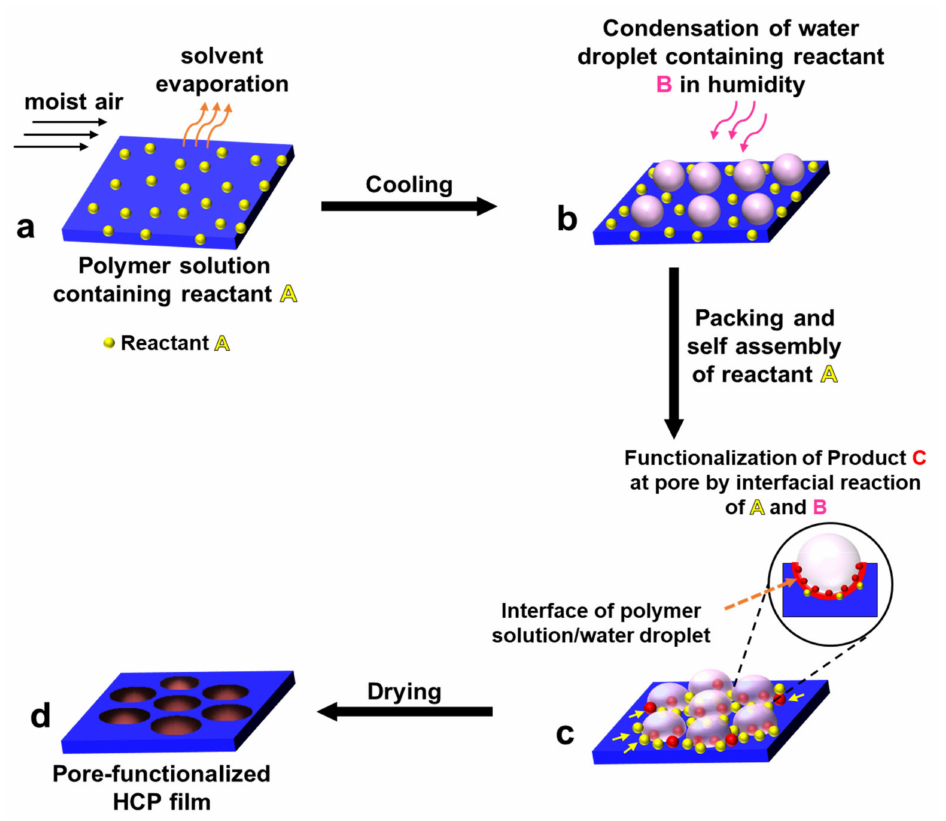
Figure 11. A sequence of stages of pore-selective functionalization by self-assembly accompanied by chemical reaction. ( a ) polymer solution containing reactant A, ( b ) condensation of water droplets containing counter reactant B, ( c ) functionalizing of product C at the pore by the interfacial